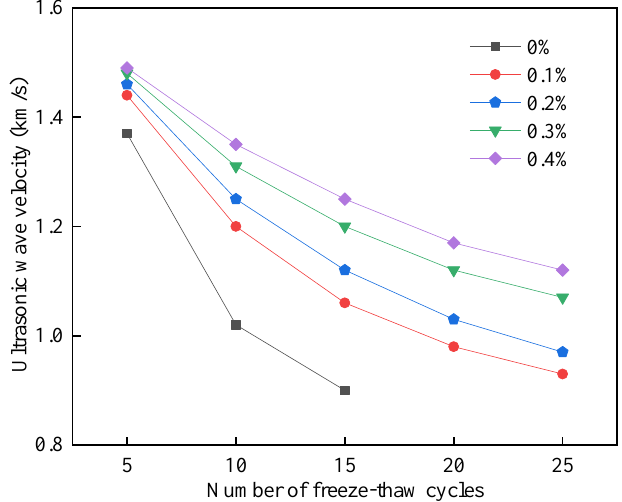
Figure 27. Ultrasonic wave velocity for freeze – thaw cycle test.